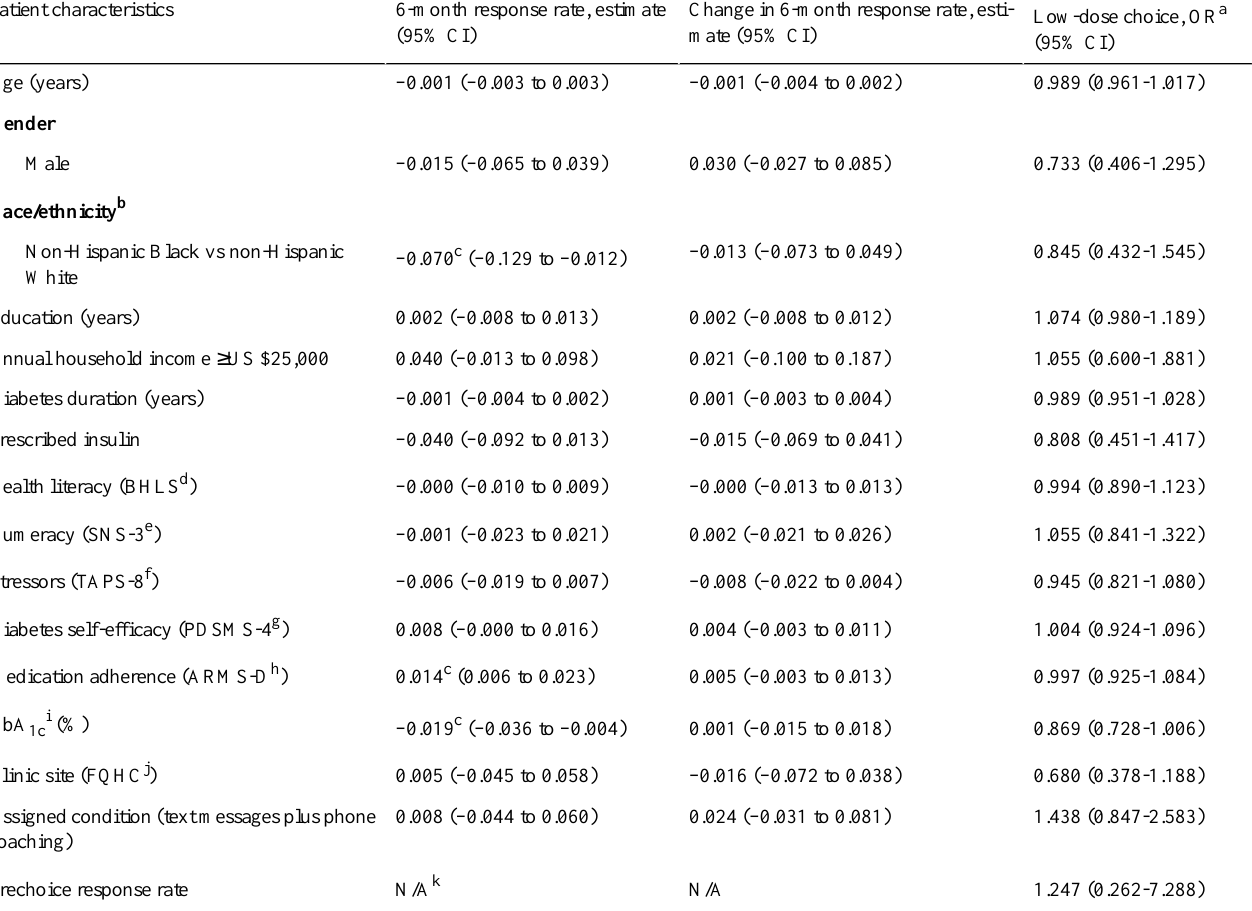
Table 3. Associations between patient characteristics and engagement.